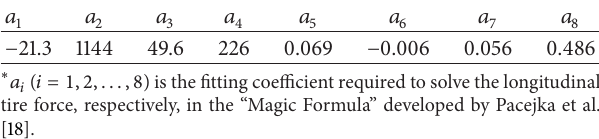
Table 1: Basic parameters of the vehicle. Table 2: The fitting coefficients of the “Magic Formula” ∗ .